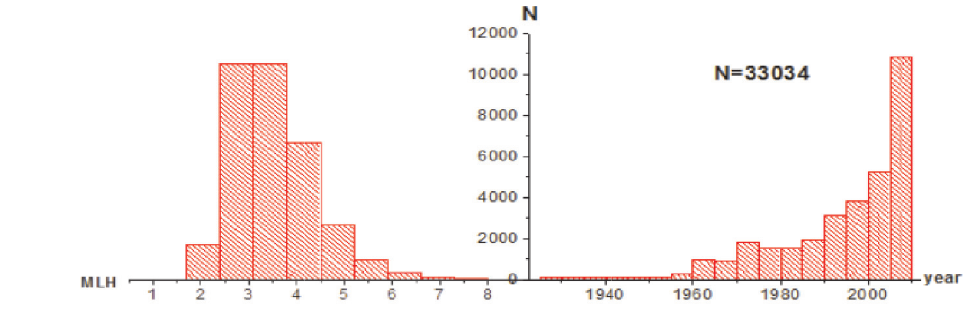
Figure 6. Right: distribution of earthquakes by years in the EMCA catalogue. Left: distribution of earthquakes by MLH magnitude.